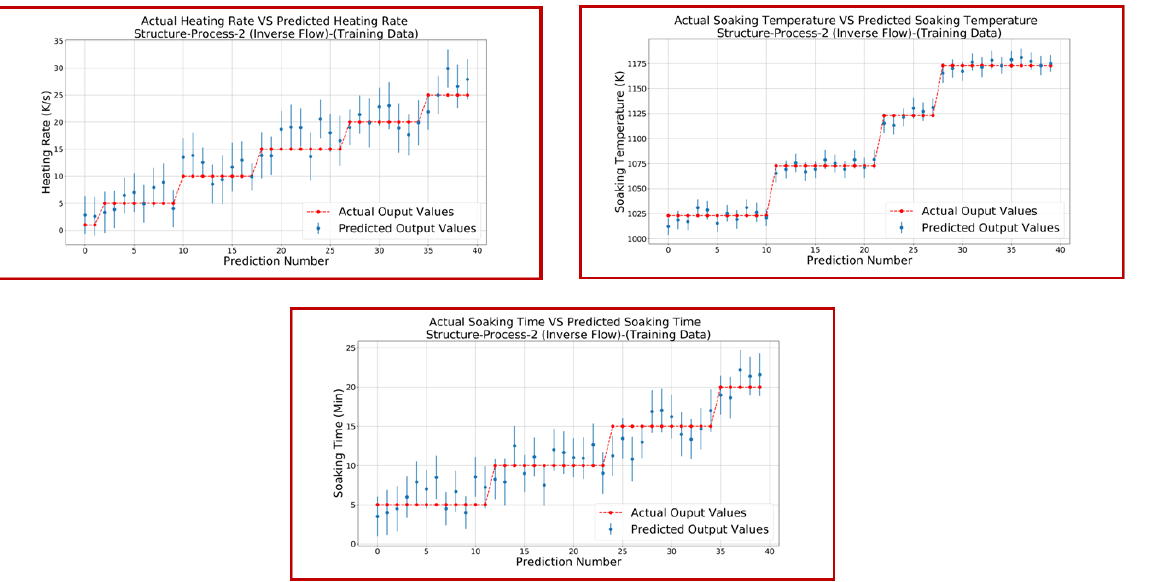
Figure 12. Feasible Region of the Processing Parameters (Forming and Quenching).